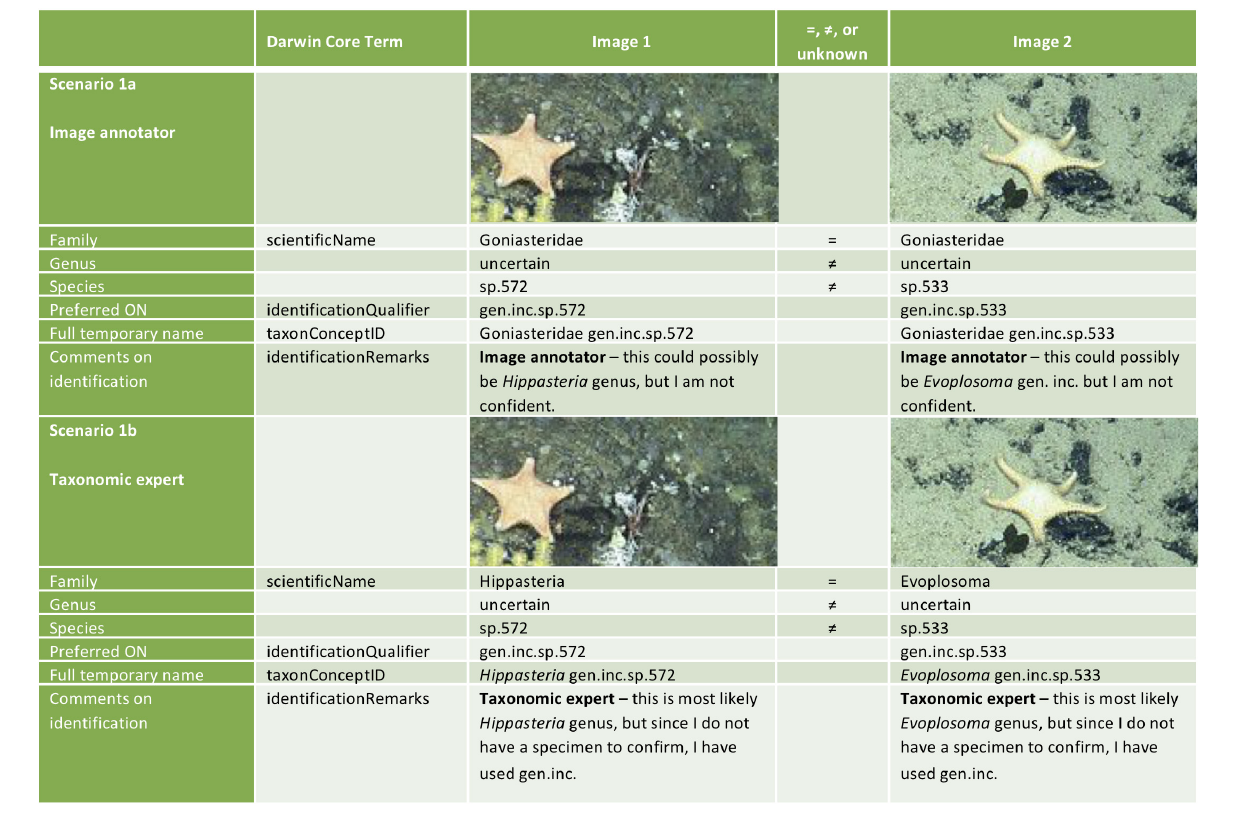
should be amended to the format Paroriza sp. [unique123]